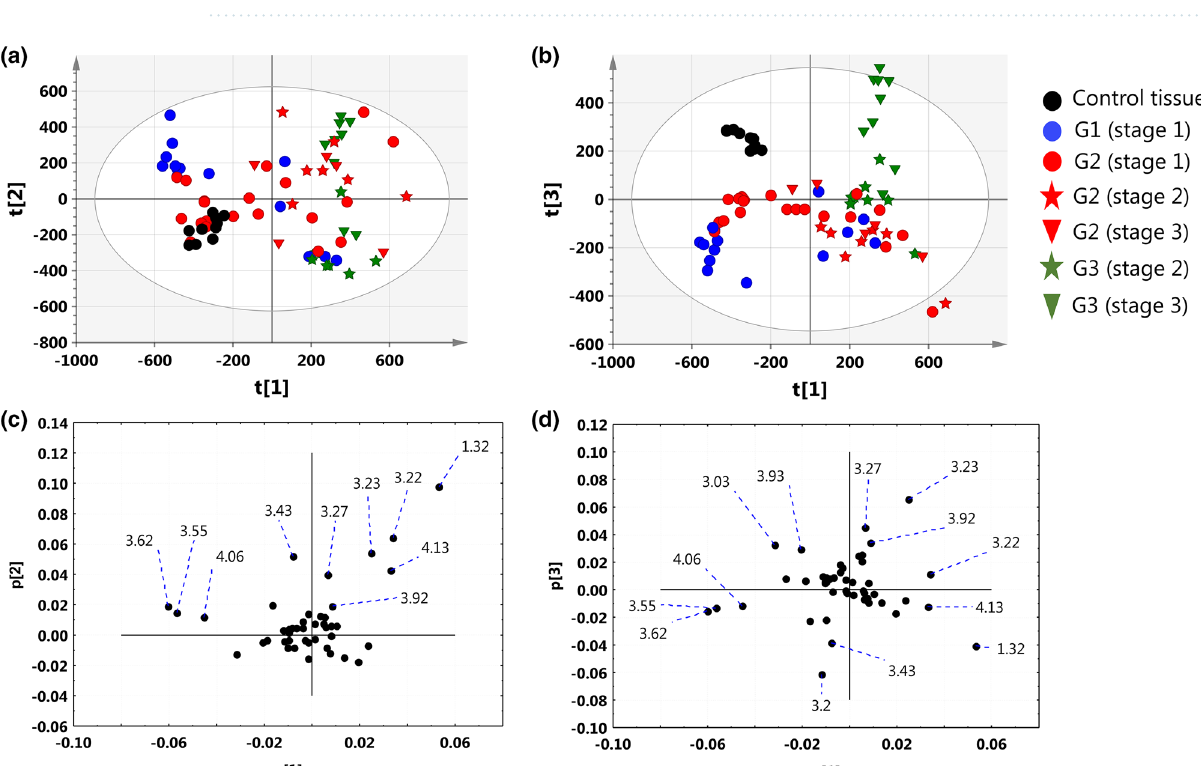
Figure 3. The PCA scores plots obtained from the model 1 (in the parentheses there are the percentage values of the total variation in the given projection plane) for: ( a ) PC1–PC2 (44.2%), ( b ) PC1–PC3 (35.41%). The loadings plots for: ( c ) PC1–PC2, ( d ) PC1–PC3. The points in the scores plots are marked according to the disease stage and tumors grade, while the points in the weights plots are labeled according to the chemical shifts. For clarity, the most important chemical shifts are presented. The scores plots ( a , b ) were created using SIMCA-P 15.0 software package (https:// www. sarto rius. com). The loadings plots ( c , d ) were created using Statistica 12.5 software (www. stats oft. pl) based on data exported from SIMCA-P 15.0 software package (https:// www. sarto rius.